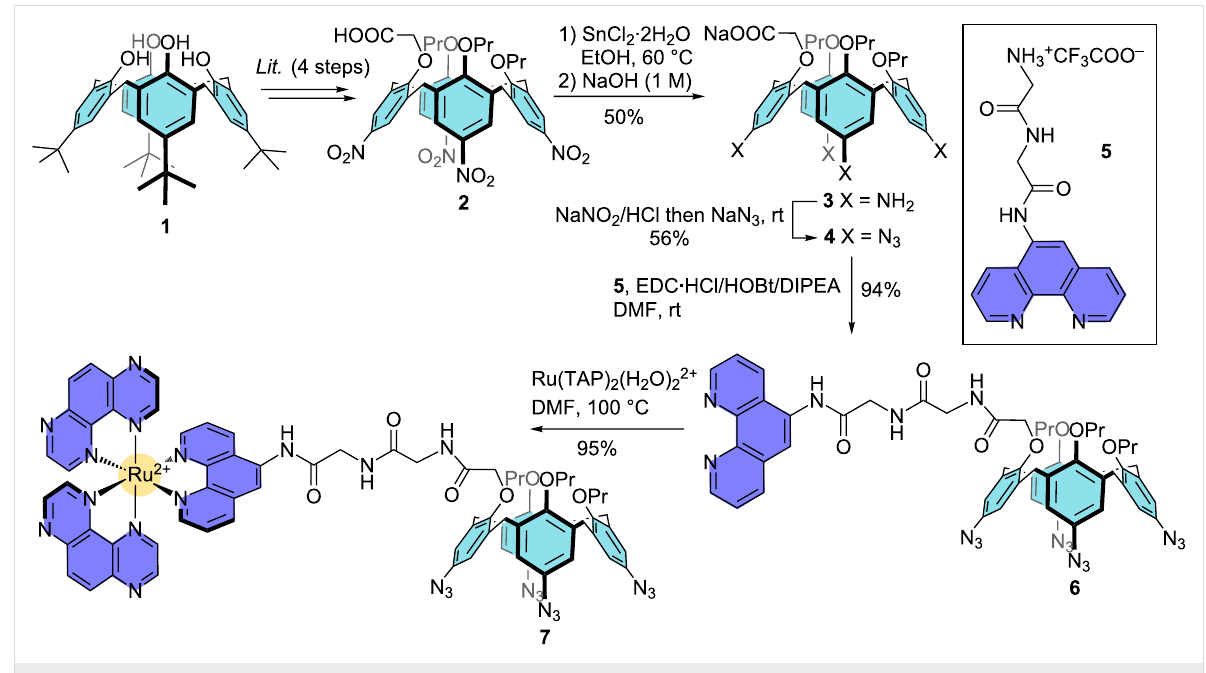
Scheme 1: Synthesis of Ru II -calix[4]arene complex 7 .